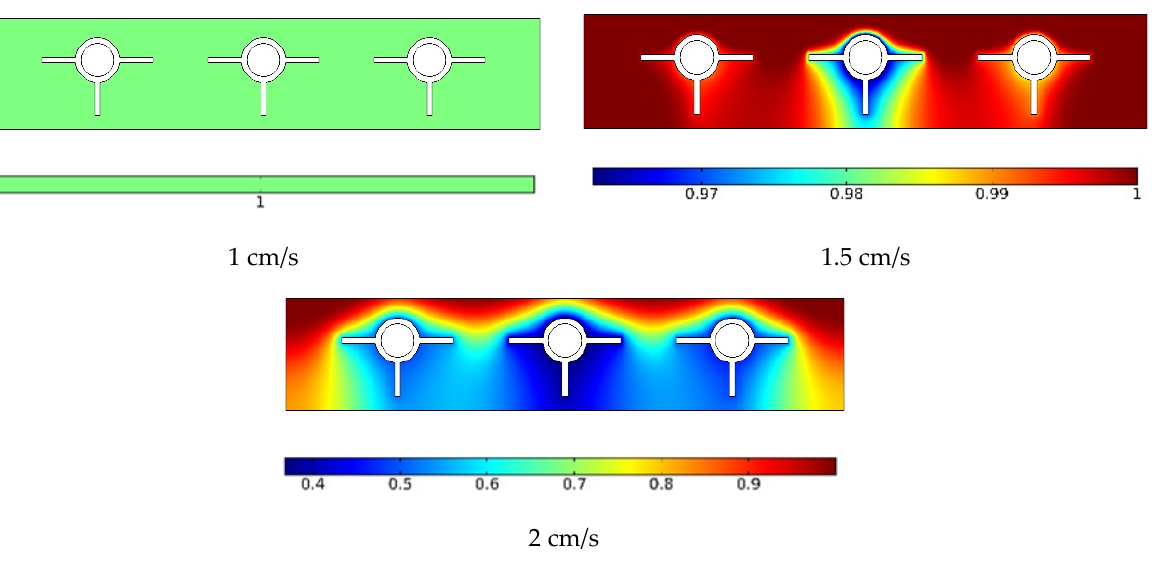
Figure 10. The melted PCM volume fraction in the vertical middle section at three velocities.